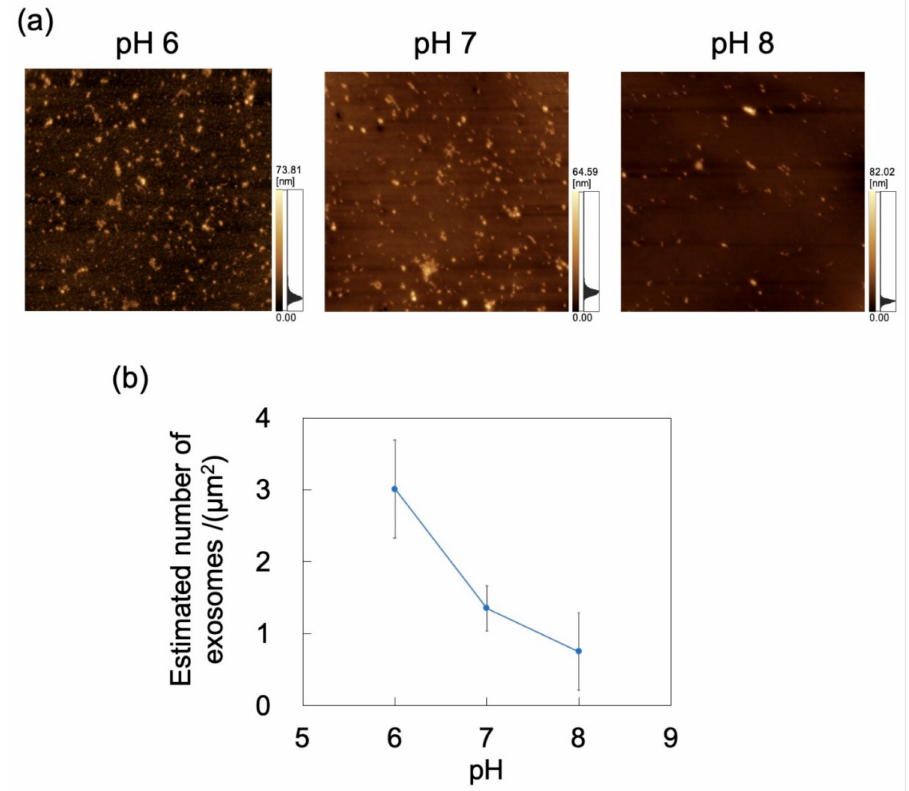
Figure 9. Adsorption of exosomes on a PDMS microchannel exposed to exosome dispersions with different pH at a constant flow rate of 0.7 mL/h. ( a ) Atomic force microscopy images of exposed polydimethylsiloxane (PDMS)-based microchannels. Scan area = 8 µ m × 8 µ m. ( b ) Number of exosomes adsorbed on PDMS-based microchannel ( n = 5) as a function of pH. Error bars represent